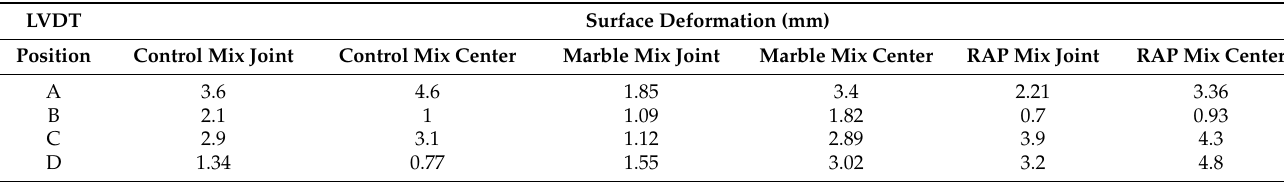
Figure 8. Deformation after loading ( a ) over the joint; ( b ) over the center. (Red Arrow – Depth of deformation). Table 8. Field Simulation Test